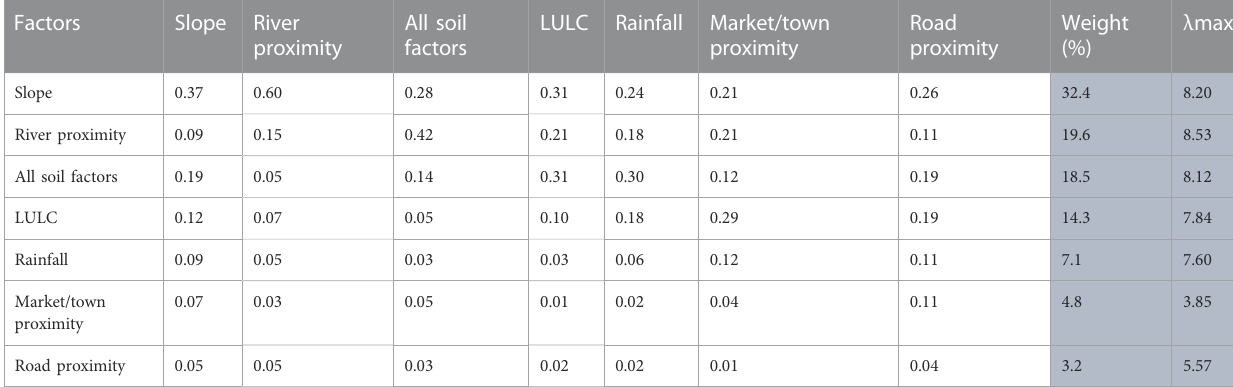
TABLE 11 Standardized pair-wise comparison and weight of all the factors considered to determine the surface irrigation potentials of the Chacha Watershed. Factors